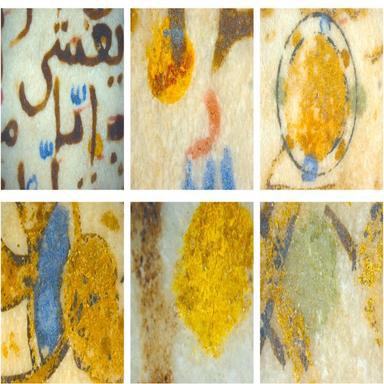
Macro (up) and micro (down) details of the colours found in the Koran. On fol.30r, from left to right: lapis lazuli blue and gold, arsenic based yellow and a green copper proteinate.